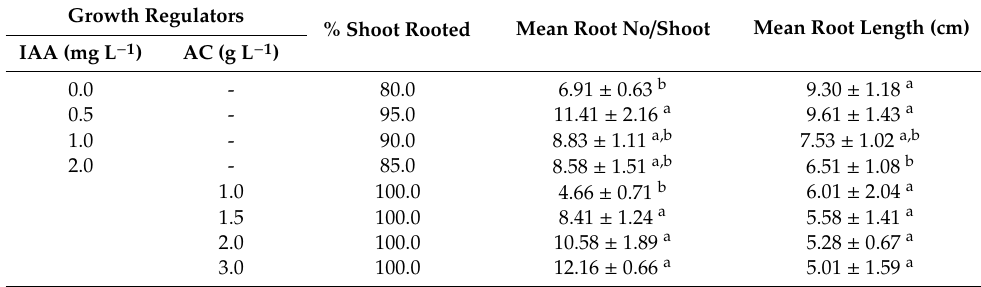
Figure 6. A. longiloba plantlets obtained from in vitro culture and acclimatization process; ( A ) In vitro plantlets ready to be acclimatized; ( B ) plantlets taken out from culture vessel about 9–10 cm tall; ( C ) acclimatized plant in the green house where there is 100% shade; ( D ) A. longiloba plant after 45 d of acclimatization. Table 5. Effect of auxins on in vitro root induction in micro-propagated shoots after four weeks of culture.